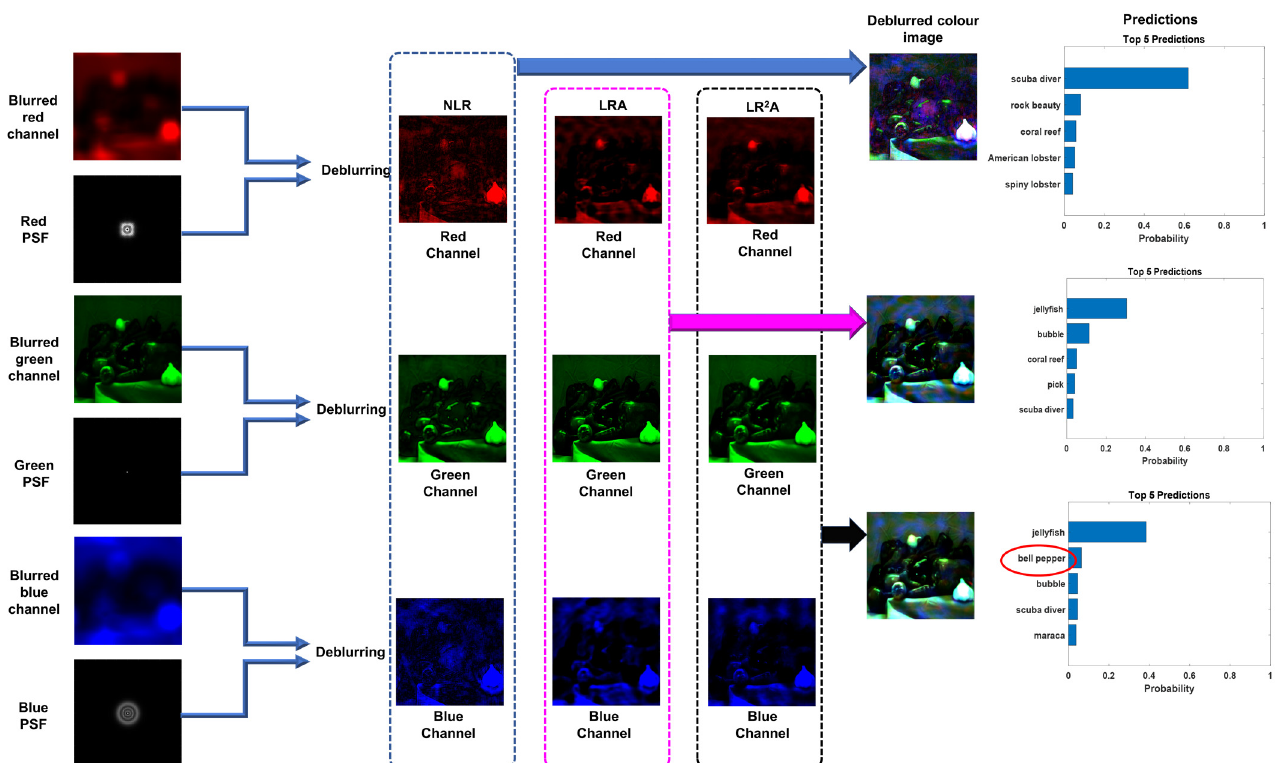
Figure 10. Method of deblurring di ff erent color channels using LRA, NLR, and LR 2 A, fusing them into a color image and classi fi cation of the resulting deblurred image using GoogLeNet. The red circle indicates that the second most probable case is bell pepper when LR 2 A was used.